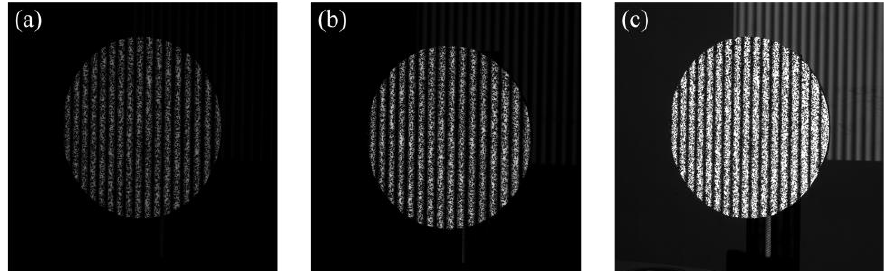
Figure 12. Images acquired at different exposure times. ( a ) Exposure time of 20 ms; ( b ) exposure time of 40 ms; ( c ) exposure time of 80